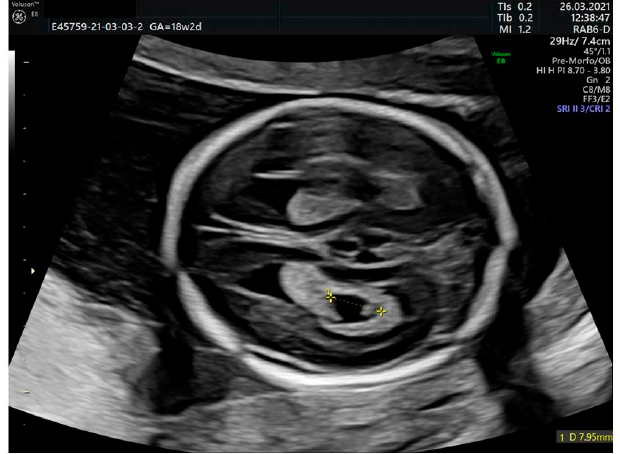
Figure 2. Choroid plexus